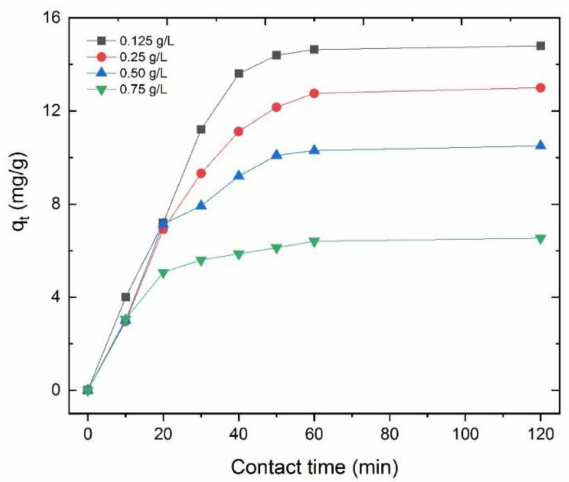
Figure 9. Influence of adsorbent concentration in the terbium adsorption process. Feed phase: 0.005 g/L Tb at pH 5. Temperature: 25 ◦ C.